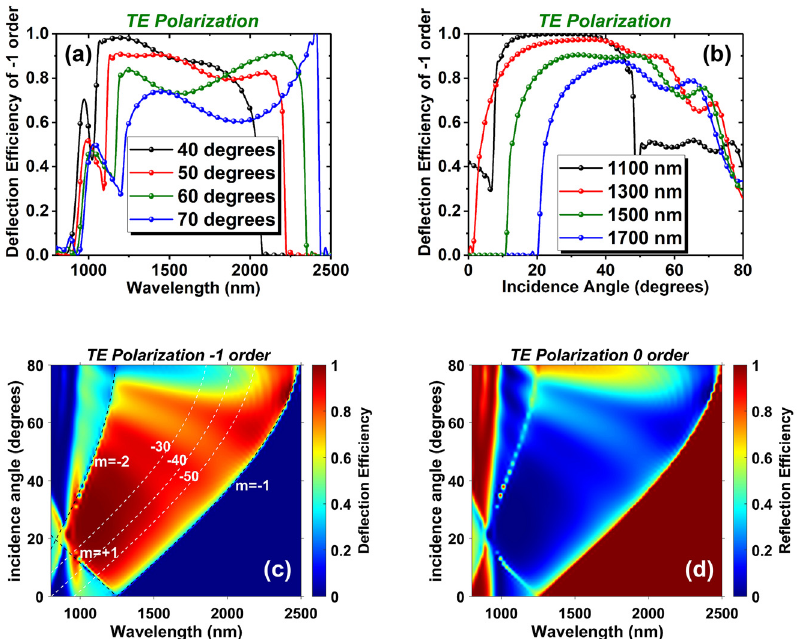
Figure 2: Ultra-wideband and wide-angle deflection in case of TE polarization. Simulated − 1st order de fl ection ef fi ciency, r − 1 , as a function of (a) wavelength, λ and (b) incidence angle, θ . Contour plots of the simulated de fl ection/specular re fl ection ef fi ciency, r m ,for(c) m = − 1 and(d) m =0.In plot (c), the dashed white lines represent isolines for de fl ection angle, ϕ − 1 ( m = − 1), which is equal to − 30 ° , − 40 ° , and − 50 ° ; the dashed black lines approximately show cutoffs, i.e., the boundaries of the regions, wheretheorders m = − 1, m = − 2,and m = + 1 maypropagate(ontheleftsidewithrespect to each of these